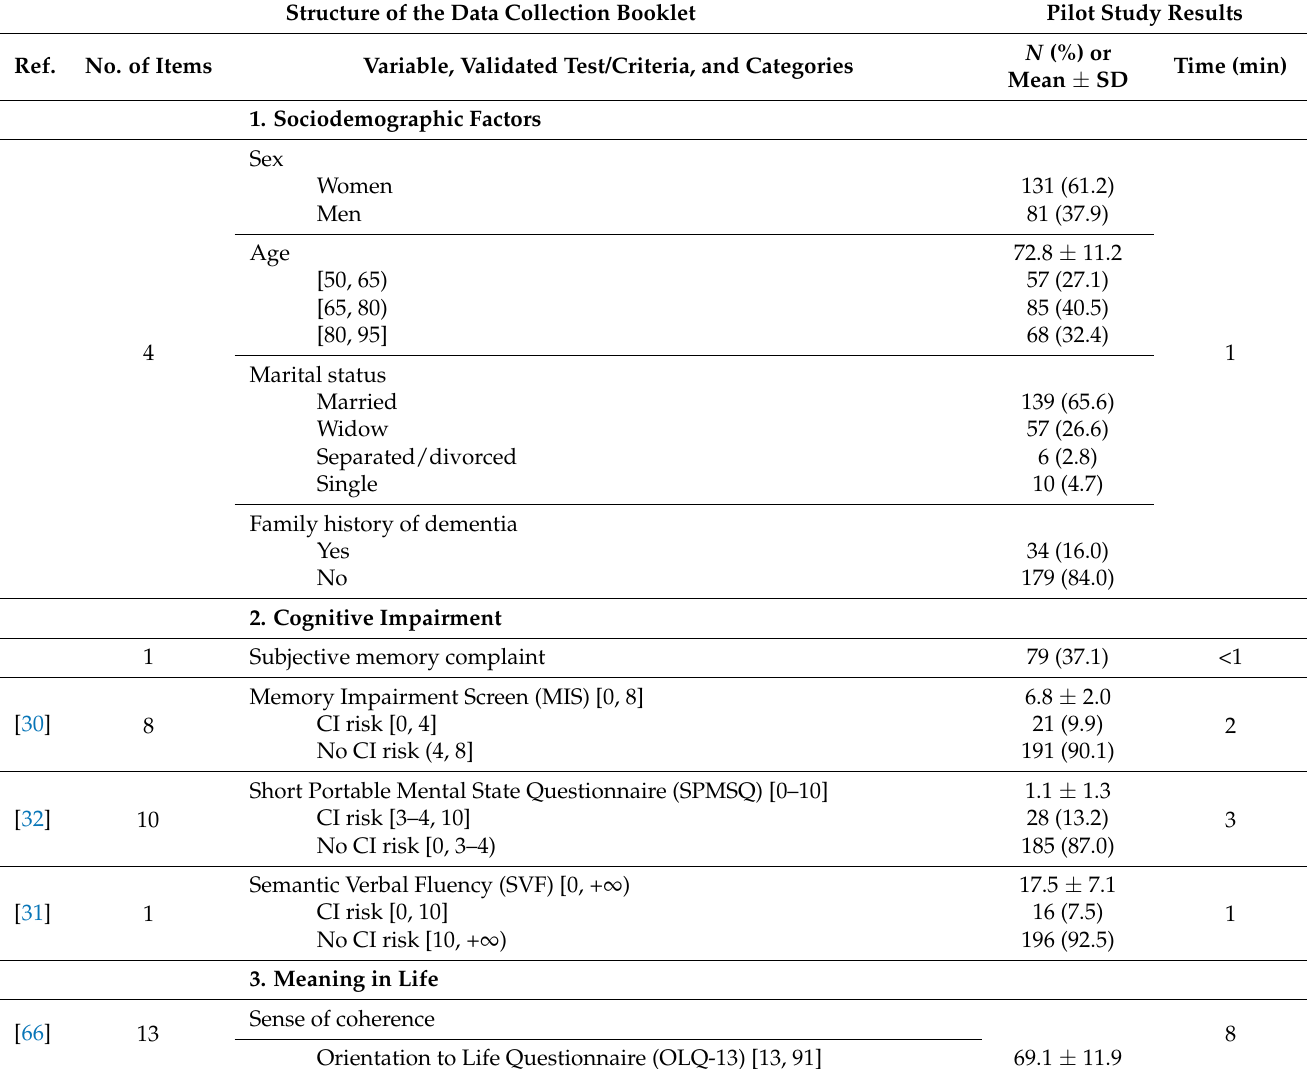
Structure of the Data Collection Booklet Pilot Study